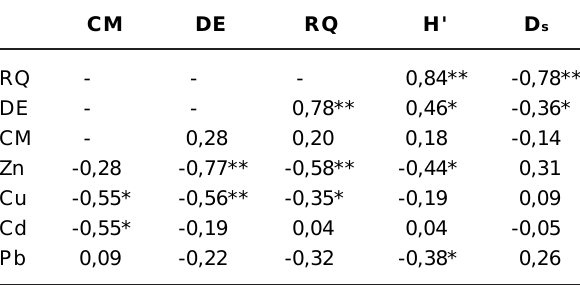
Figura 1. Espécies de fungos micorrízicos arbusculares (FMA) nas amostras de solo contaminado com metais pesados e suas freqüências de ocorrência no conjunto dos locais de amostragem.